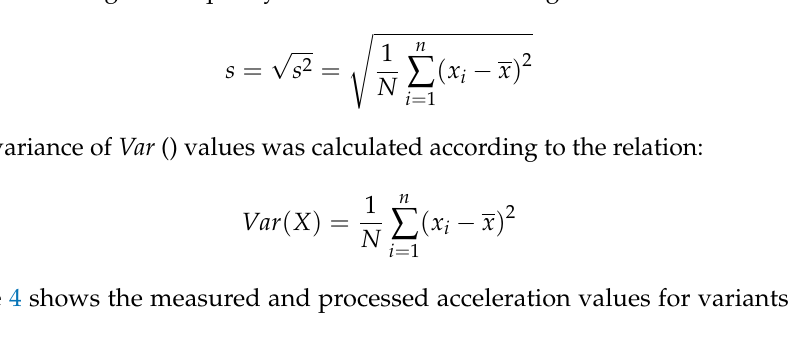
Table 4. Statistical processing of acceleration values-variants V50 to V56 (C7 and HEAD).